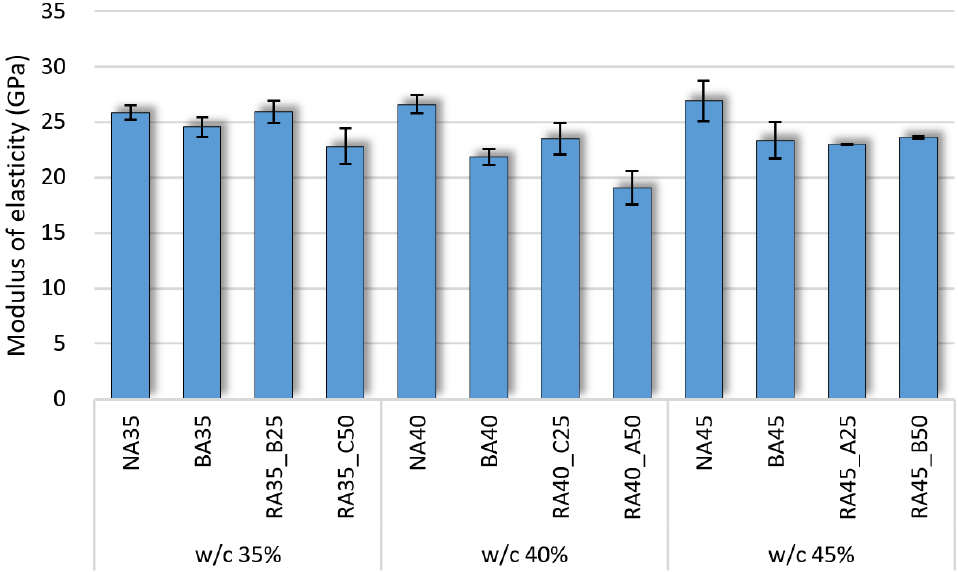
Figure 9. Modulus of elasticity of concrete specimens according to water–cement (w/c) ratio.